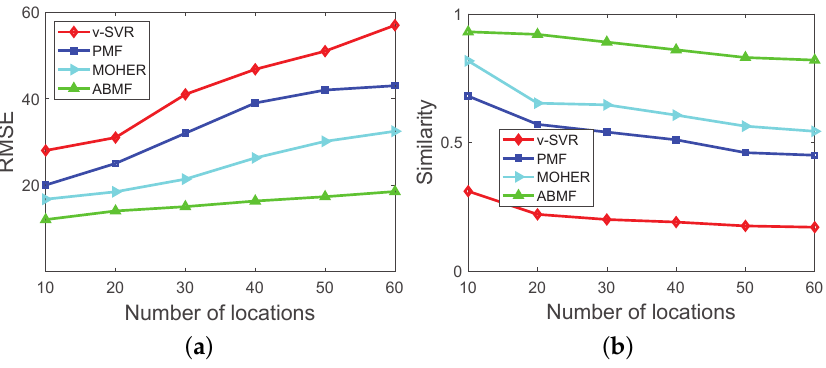
Figure 9. Performance comparison with different scale of Foursquare(NYC) dataset: ( a ) Performance on RMSE; ( b ) Performance on Similarity.